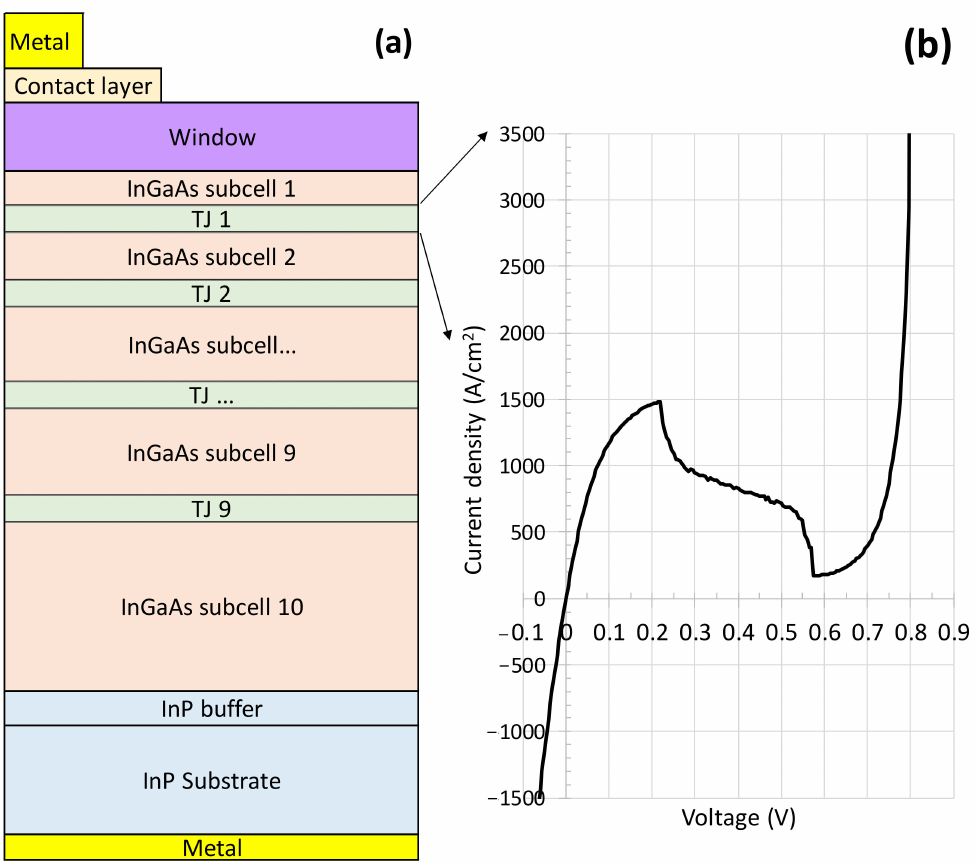
Figure 1. Schematic of the PT10-InGaAs/InP Vertical Epitaxial HeteroStructure Architecture (VEHSA design) devices prepared with 10 InGaAs subcells in ( a ), and I–V characteristics of the tunnel junction (TJ) measured from a single TJ grown separately in a truncated structure in ( b